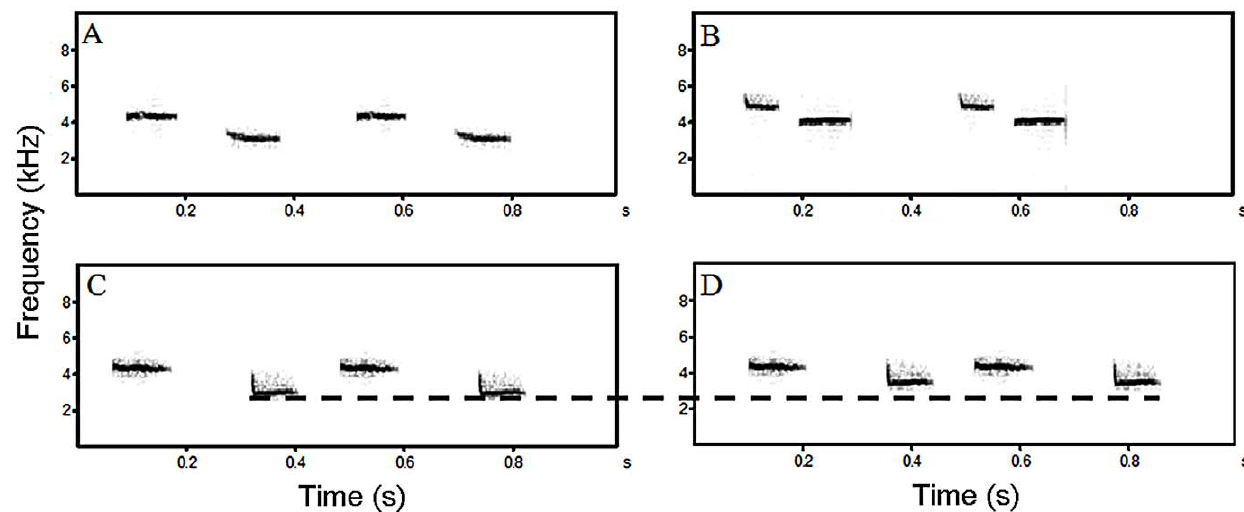
Figure 1. Sonograms showing example test sounds used in the experiment. Sounds A (rural) and B (true urban) were used in experiment 1. Sounds C (rural) and D (artificial urban) were used in experiment 2. The dotted line allows comparison between the frequency of the lower note in the original rural song (C) and its frequency after being increased by 500 Hz in artificial urban song (D).